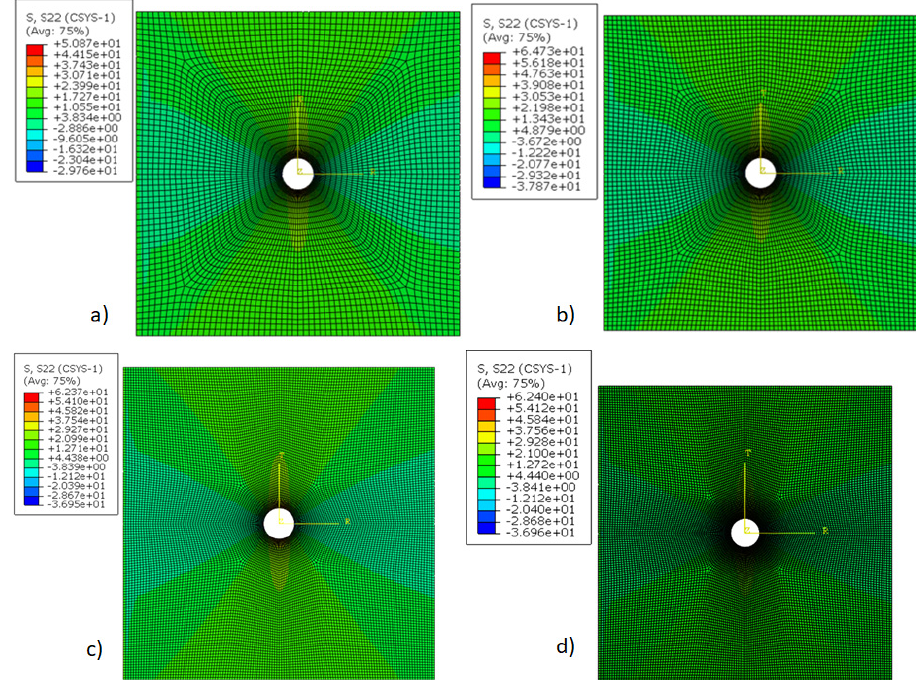
Figure 7. Mesh convergence analysis for mesh size (mm), ( a ) 1.5, ( b ) 1.2, ( c ) 0.6, ( d ) 0.2.